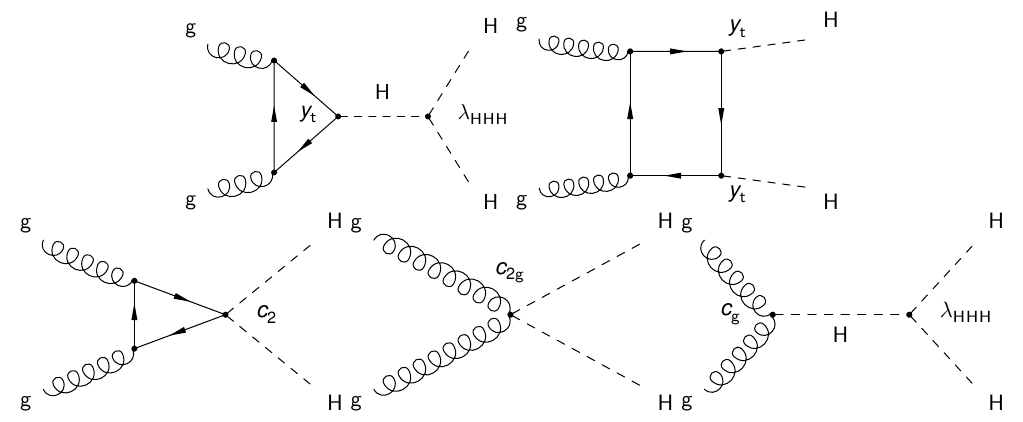
Figure 1 . Feynman diagrams of the processes contributing to the production of Higgs boson pairs via ggF at LO. The upper diagrams correspond to SM processes, involving the top Yukawa coupling and the trilinear Higgs boson self-coupling λ , respectively. The lower diagrams correspond y t HHH to BSM processes: the diagram on the left involves the contact interaction of two Higgs bosons with two top quarks ( c ), the middle diagram shows the quartic coupling between the Higgs bosons 2 and two gluons ( c ), and the diagram on the right describes the contact interactions between the 2g Higgs boson and gluons ( c ). g